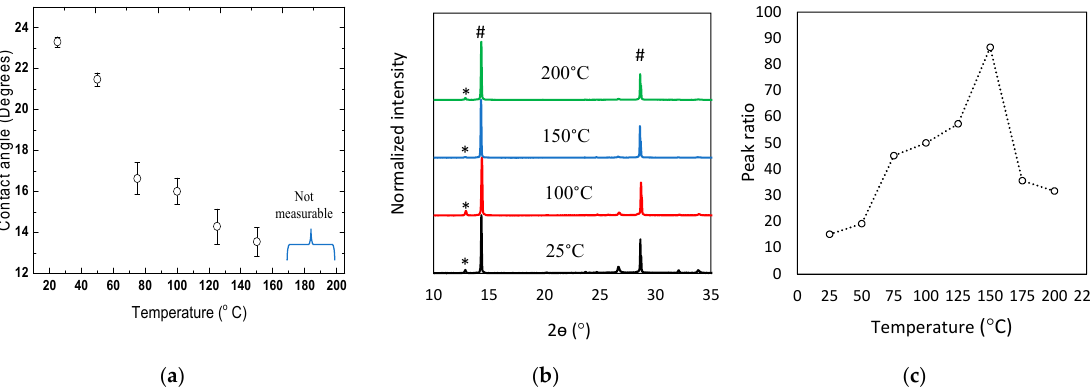
Figure 5. Employed substrte temeratures during the fabrication of perovsite films by various (large scale) techniques. (data taken from Refs. [3,7,8,13,16,18–22,24,25,30–37]). Abreviations: SC: Spray coating; DB: Doctor blading; SDC: Slot-die coating; 3D P: 3D printing based on SDC and N 2 gas-blowing; VADC: Vibration-assisted drop casting; RC: Roller coating; IJP: Inkjet printing.